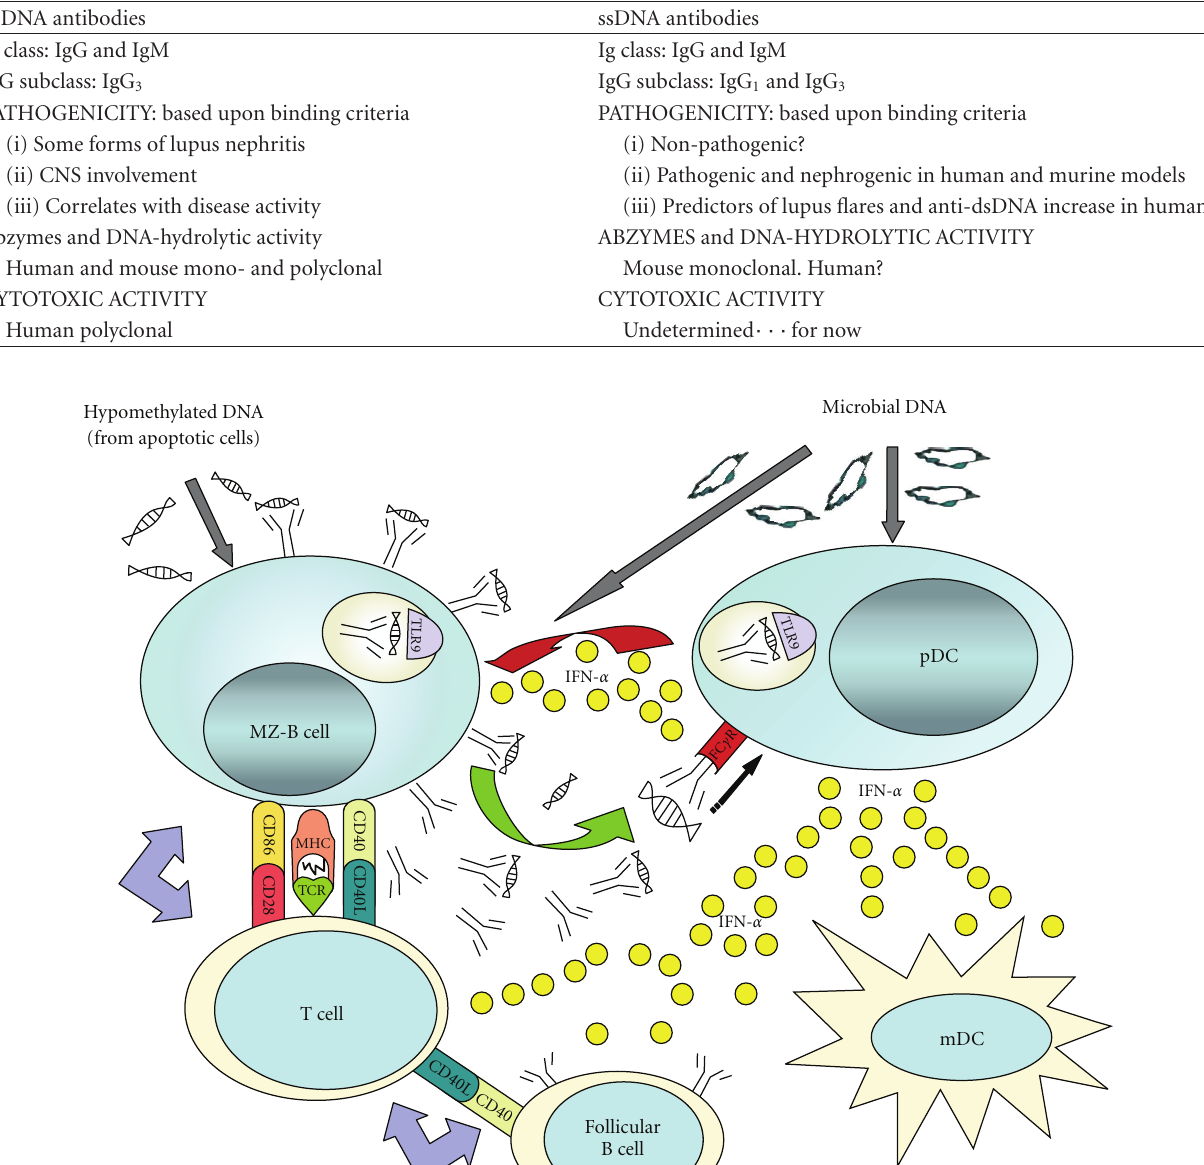
Table 3: Anti-DNA autoantibodies properties.